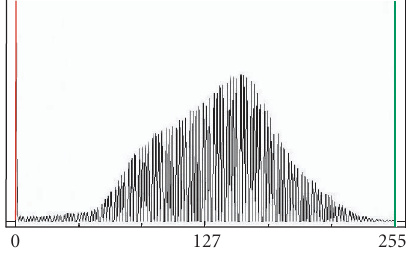
Figure 4.6. Histogram of area from Figure 4.3 where fire is later detected.